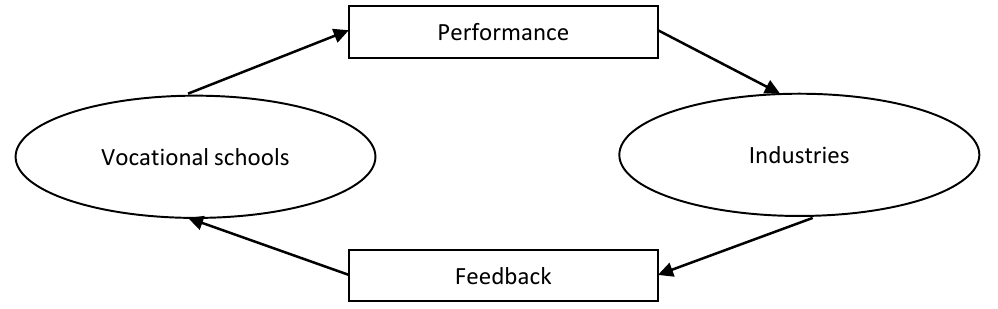
Figure 2. The reciprocal relationship between vocational schools and